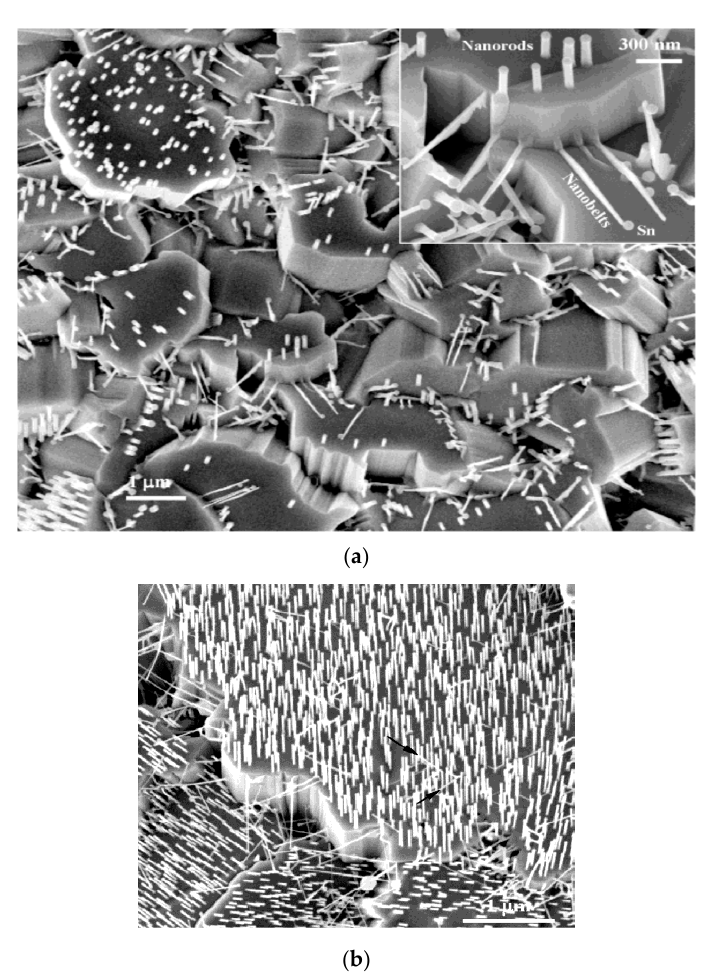
Figure 11. ( a ) Scanning electron microscope (SEM) image showing ZnO nanorods and nanobelts grown on the top (0001) and side surfaces of the ZnO microrods, respectively for 15 min. Inset: Magnified SEM image. ( b ) SEM image of ZnO nanorods and nanobelts after growing for 30 min at 1100 ◦ C. Black arrows indicate nanobelts. Reproduced from [205] with permission of the American Chemical Society.